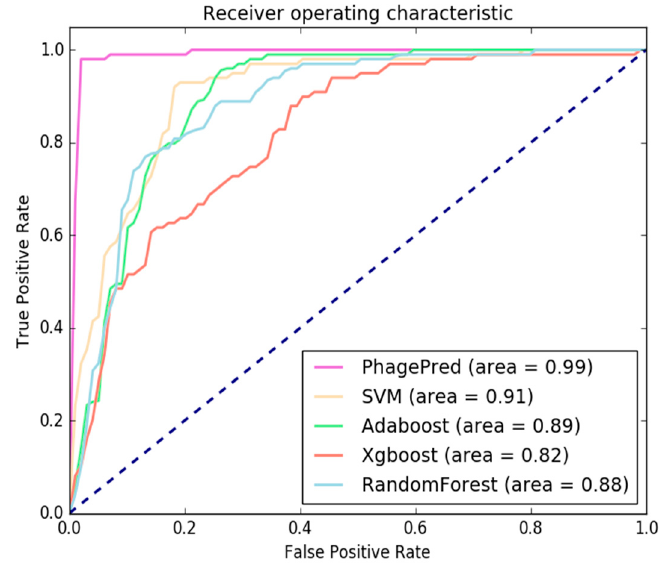
Figure 4. The receiver operating characteristic (ROC) curves calculated from the 10-fold cross-validation of the five different classifiers.